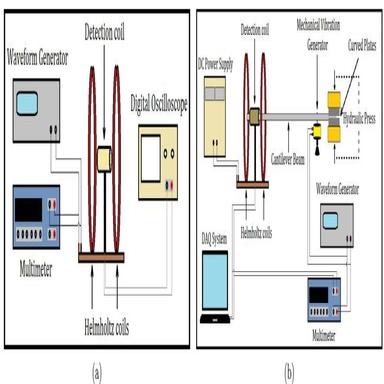
Schematic diagram of the connections between the devices in the experimental setups: (a) FR setup and (b) NFR setup.